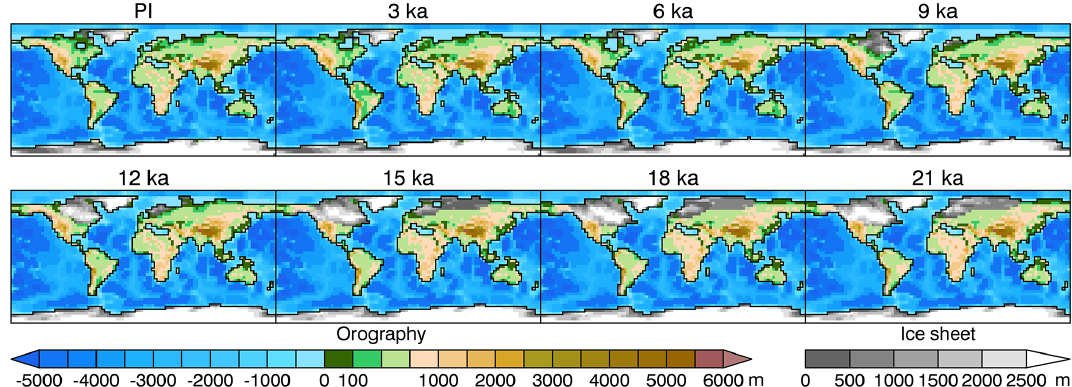
Figure 2. Orography for the time slice simulations, with ice sheet height and extent derived from ICE-4G (Peltier, 2002) for the Fennoscan- dian, Cordilleran, and Antarctic, and OSU-LIS (Licciardi et al., 1998) for the Laurentide.